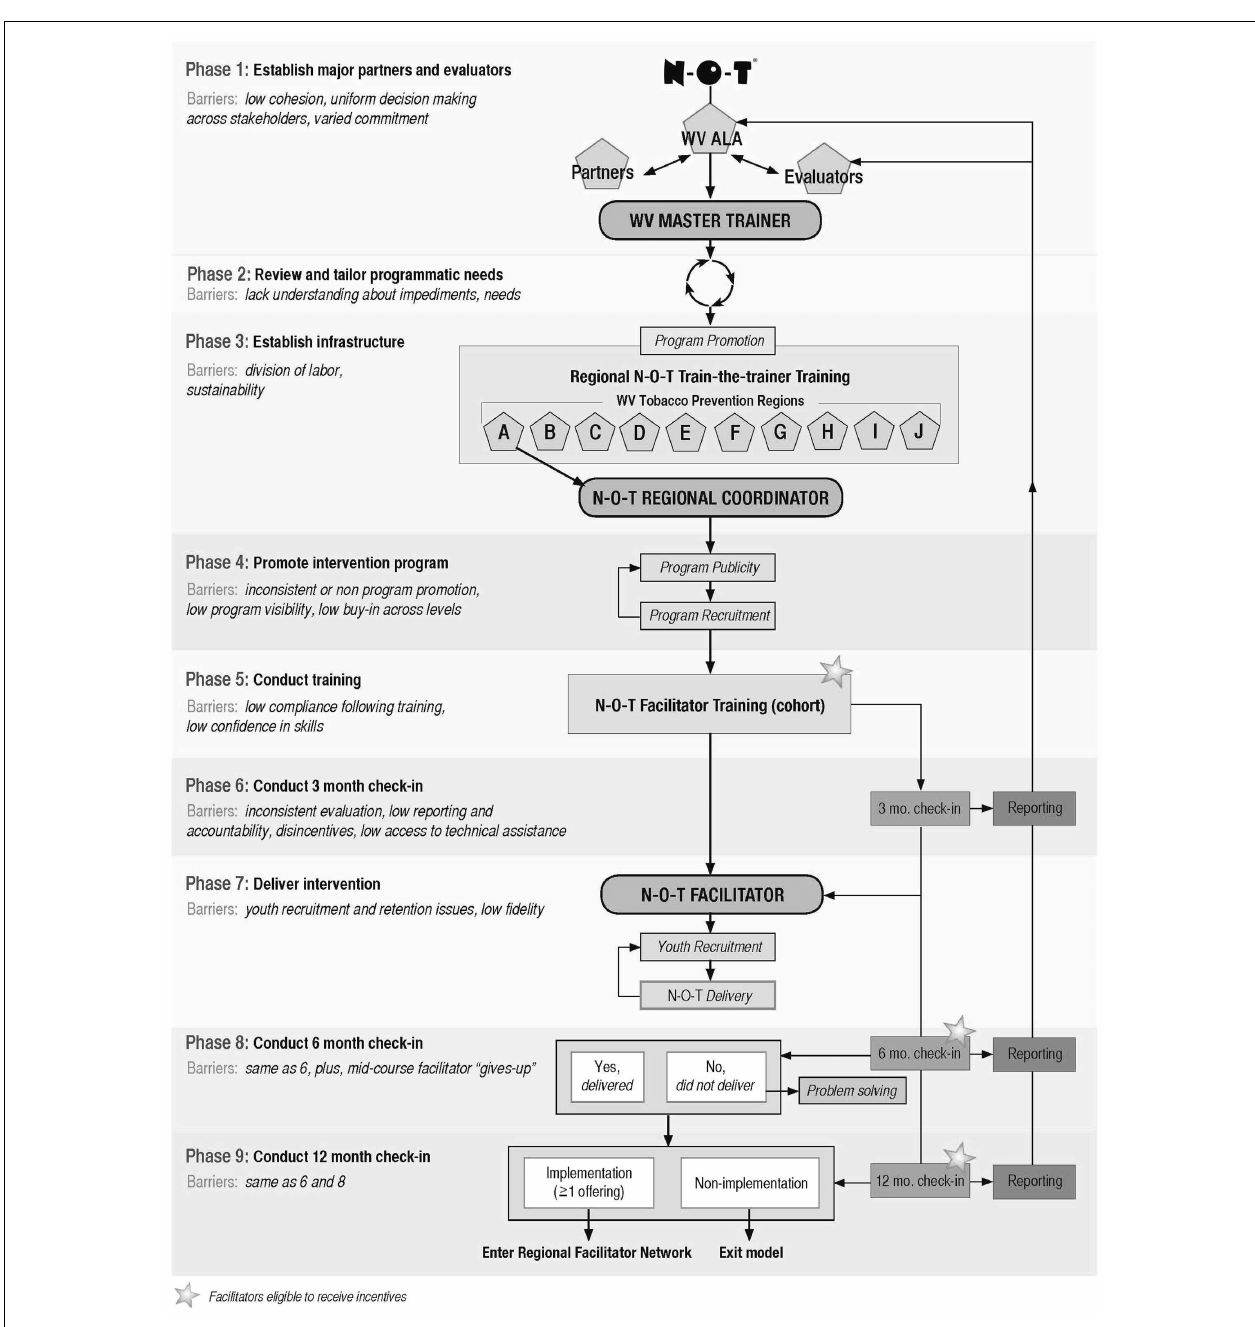
FIGURE 1 | N-O-T dissemination model